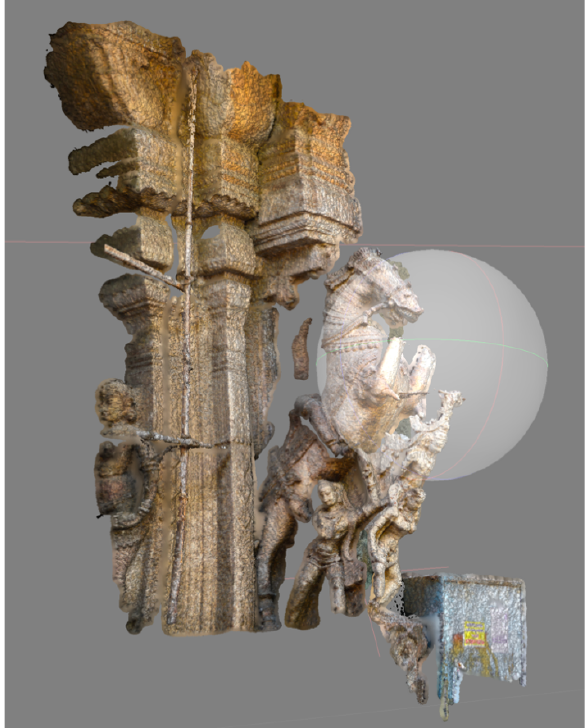
Figure 11. Left: Pen and ink drawing of a column with an equestrian figure at the entrance of the Pudu Mandapam Anonymous; Pen and ink on paper; Date: c.1801 - 1805; © British Library Board Shelfmark: WD1063, Right: Photograph of West front 2018 (OP)